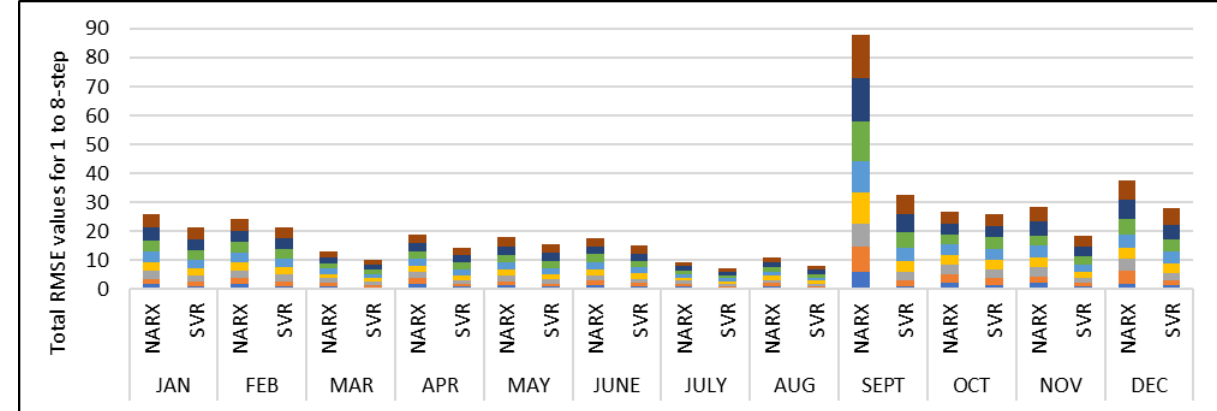
Figure 9. The performance of NARX and SVR, calculated monthly for the 2019 data.